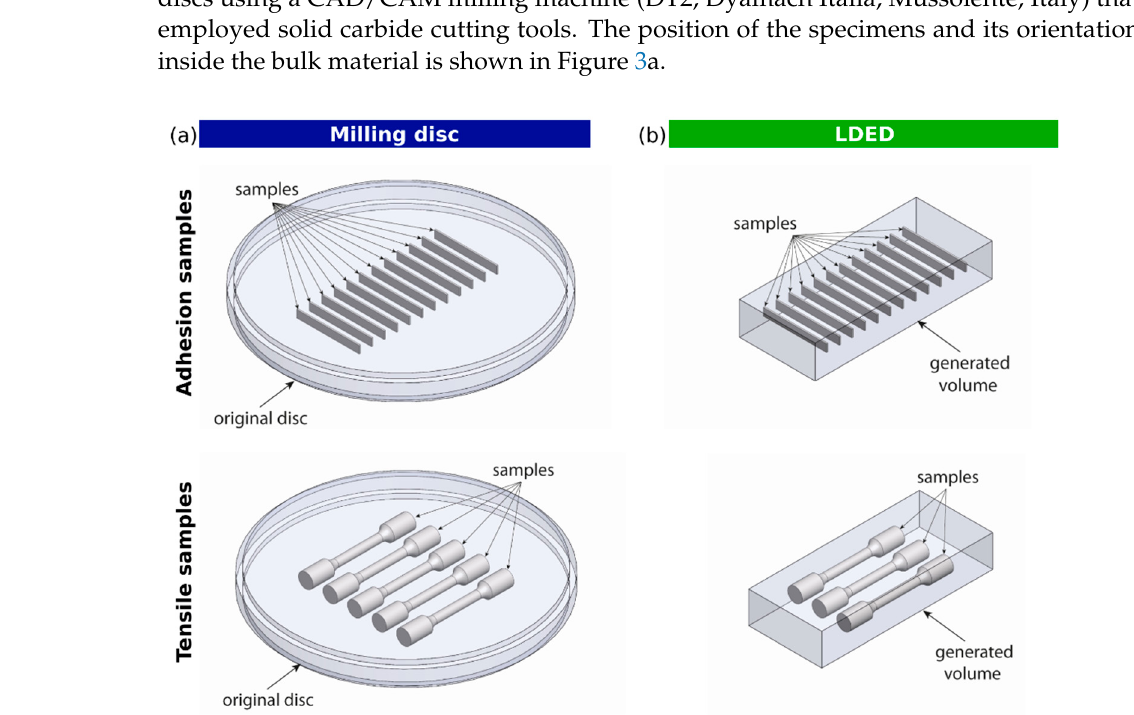
Figure 3. Representative model of the adhesion and tensile specimens’ positions inside the disc ( a ) and LDED ( b ) materials.